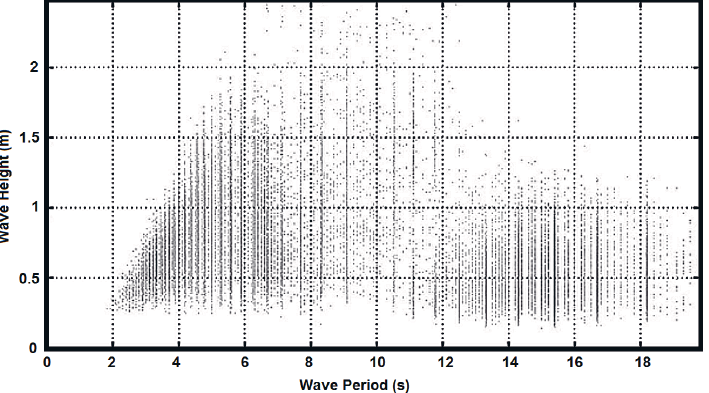
Figure 4. Wave Height and Period Scatter Plot for Bn15 (November 2006 to August